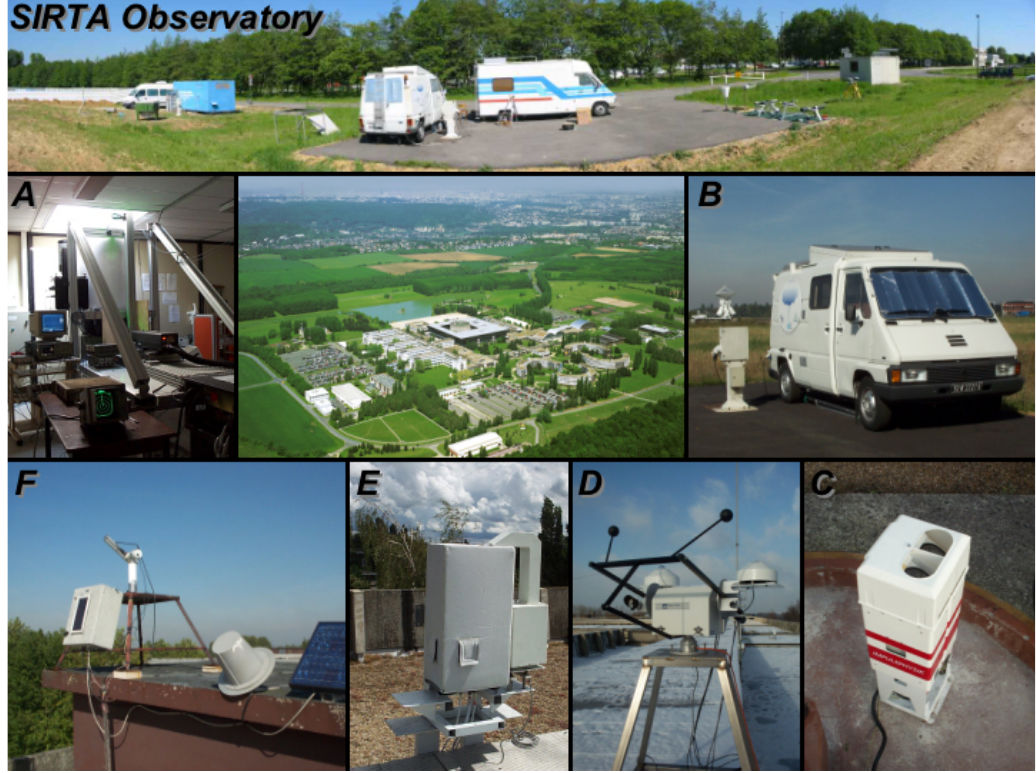
Table 1. Infrastructure of the SIRTA observatory